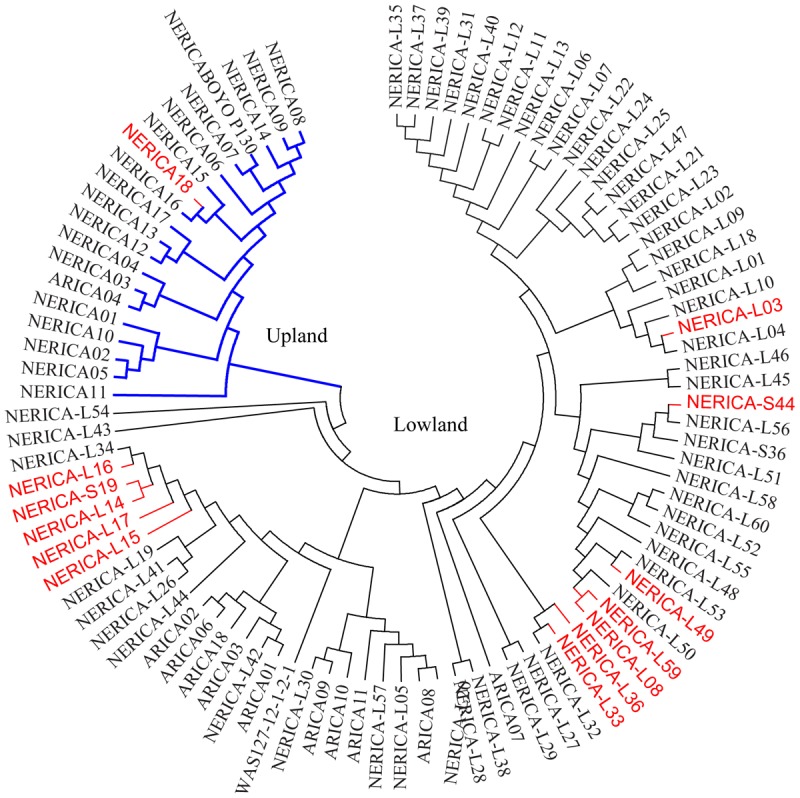
Neighbor-joining tree of 11 ARICA and 83 NERICA genotypes developed/released by Africa Rice Center based on genetic distance matrix computed from 13,849 SNPs that were polymorphic in these germplasm, each with minor allele frequency ≥0.010. Genotypes that showed ≥ 98% similarity with others are shown in red font.